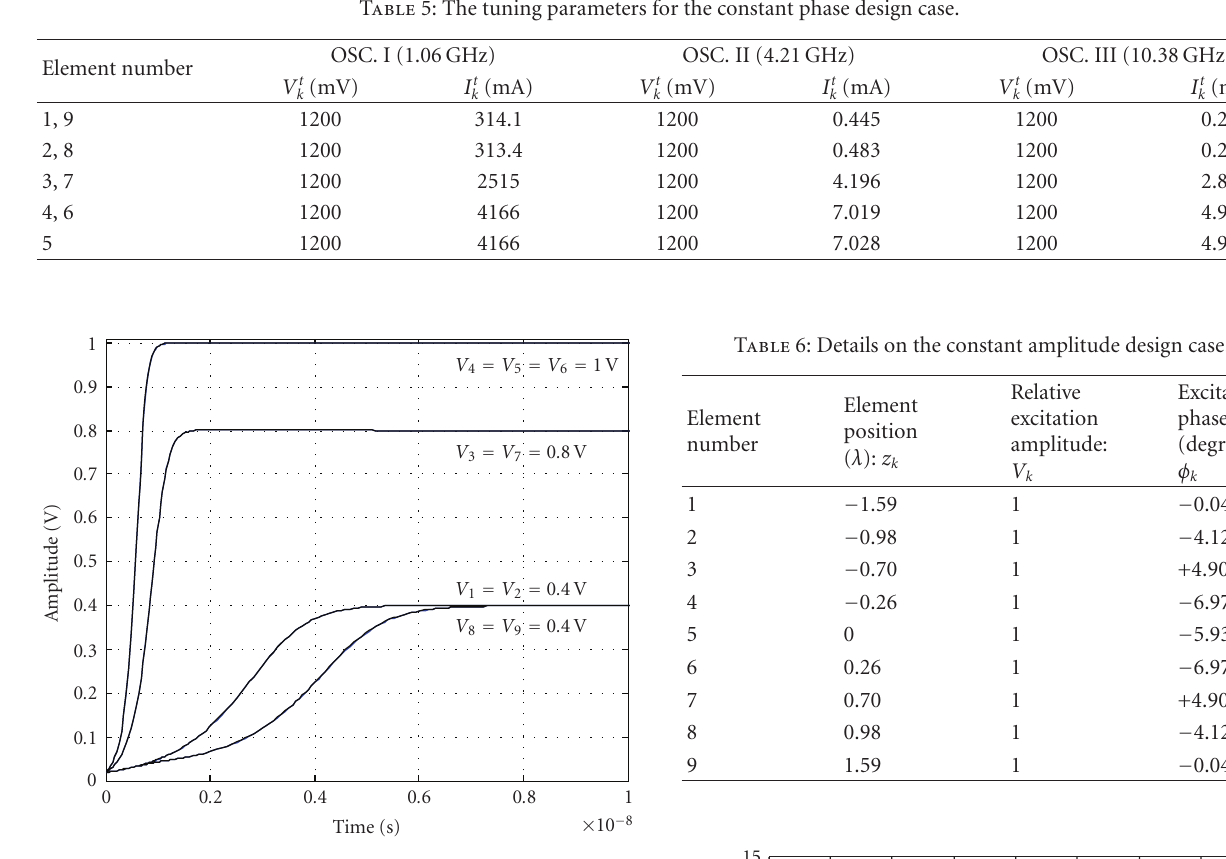
Figure 7: The coupled oscillator array response evolution with time for the constant phase design case. The evolution of the amplitudes.